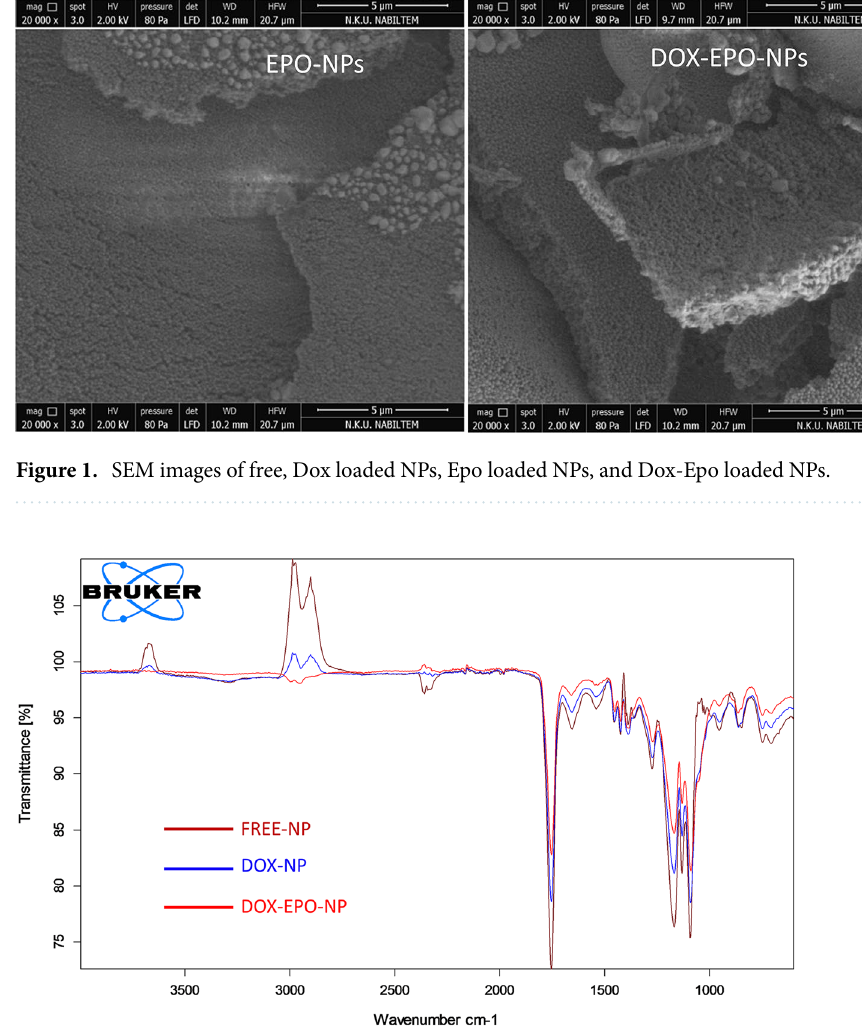
Figure 2. ATR-FTIR spectra of free NPs and NPs loaded with